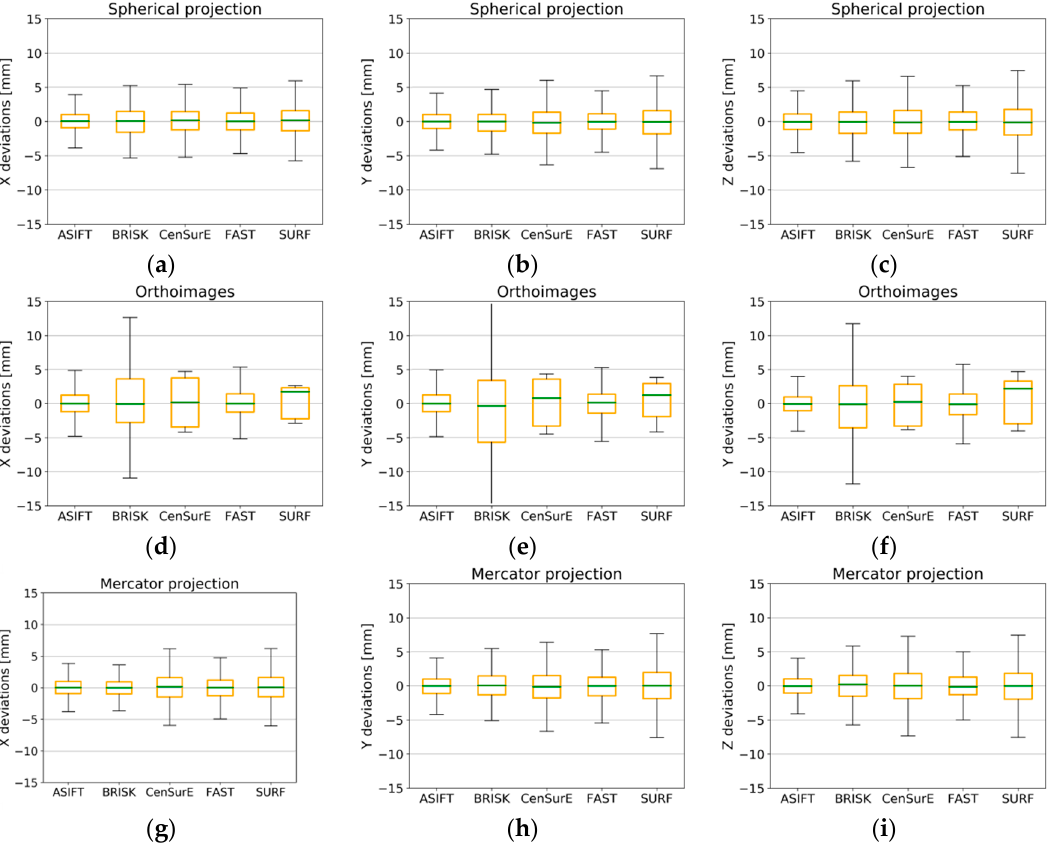
Figure 17. Box plots for the distribution of the deviations of natural control points for all pairs of fully registered scans (without points used for the ICP and non-registration) for Test Site III. The spherical projection: component—x ( a ), y ( b ), and z ( c ); orthoimages: component—x ( d ), y ( e ), and z ( f ); the Mercator projection: component—x ( g ), y ( h ), and z ( i ).